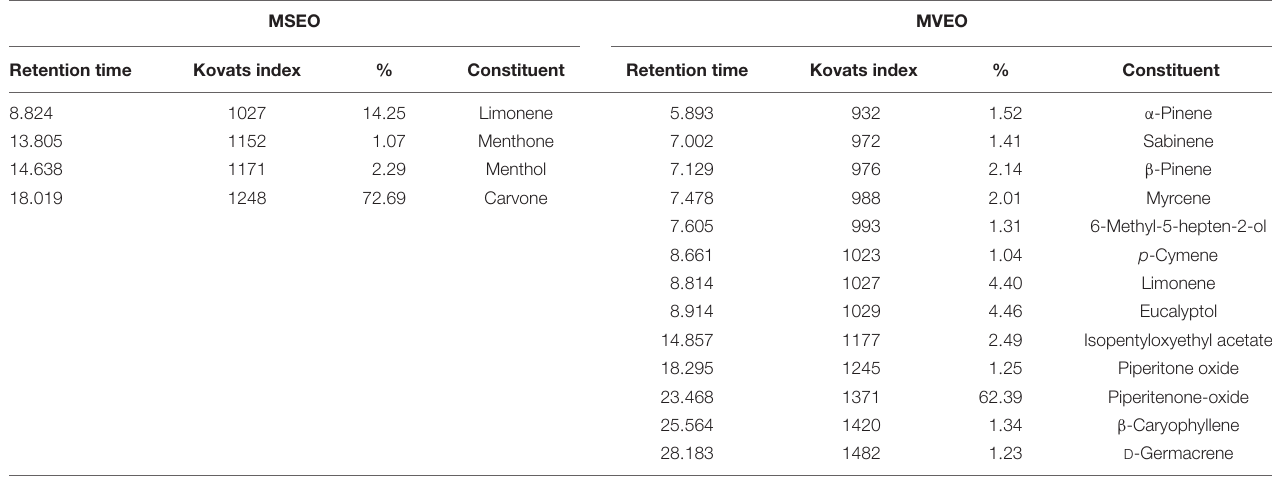
TABLE 2 | Constituents identified in the essential oil from Mentha spicata L. (MSEO) and M. × villosa Huds. (MVEO) in amounts > 1%. MSEO MVEO Retention